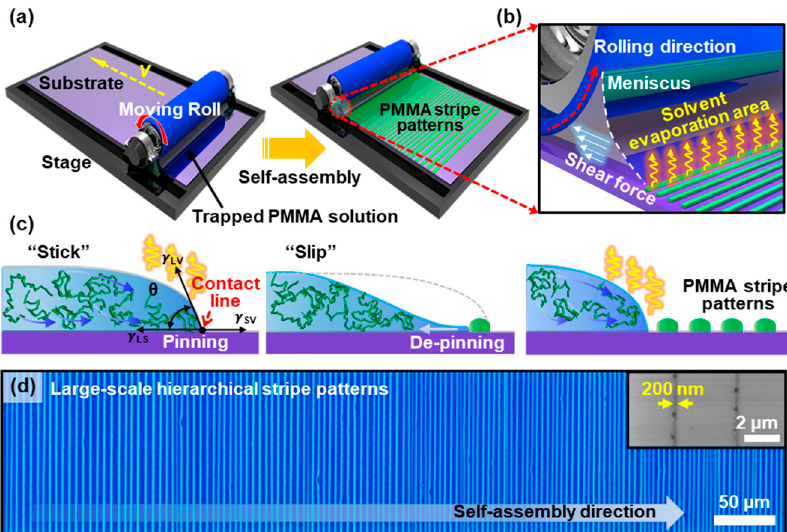
Figure 1. ( a ) Schematic illustration of the roll-on-plate geometry to form gradient stripe patterns by the solvent evaporation and controlled flow of PMMA solution. ( b ) Solvent evaporation of receding meniscus, dragged by a shear force, in confined geometry. ( c ) A cross-sectional view of cyclic stick-slip motions at the edge of the contact line, balanced with the capillary force and surface tension on a flat substrate. ( d ) Representative optical micrograph of highly ordered PMMA hierarchical stripes formed over a large area, perpendicular to the direction of the moving meniscus. Patterned stripes of PMMA in nanoscale at the final stage of the process (inset).